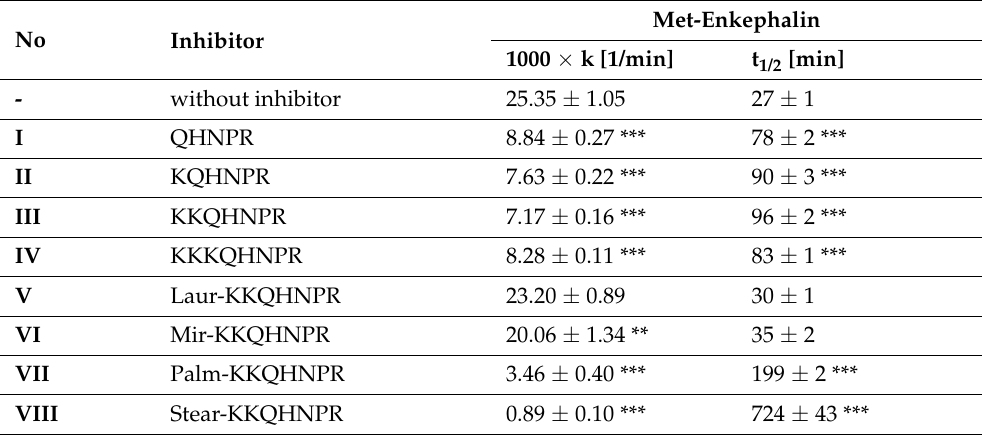
Table 2. Degradation rates (k) and half-lives (t 1/2 ) of Met-enkephalin incubated with neutral en- dopeptidase alone and in the presence of